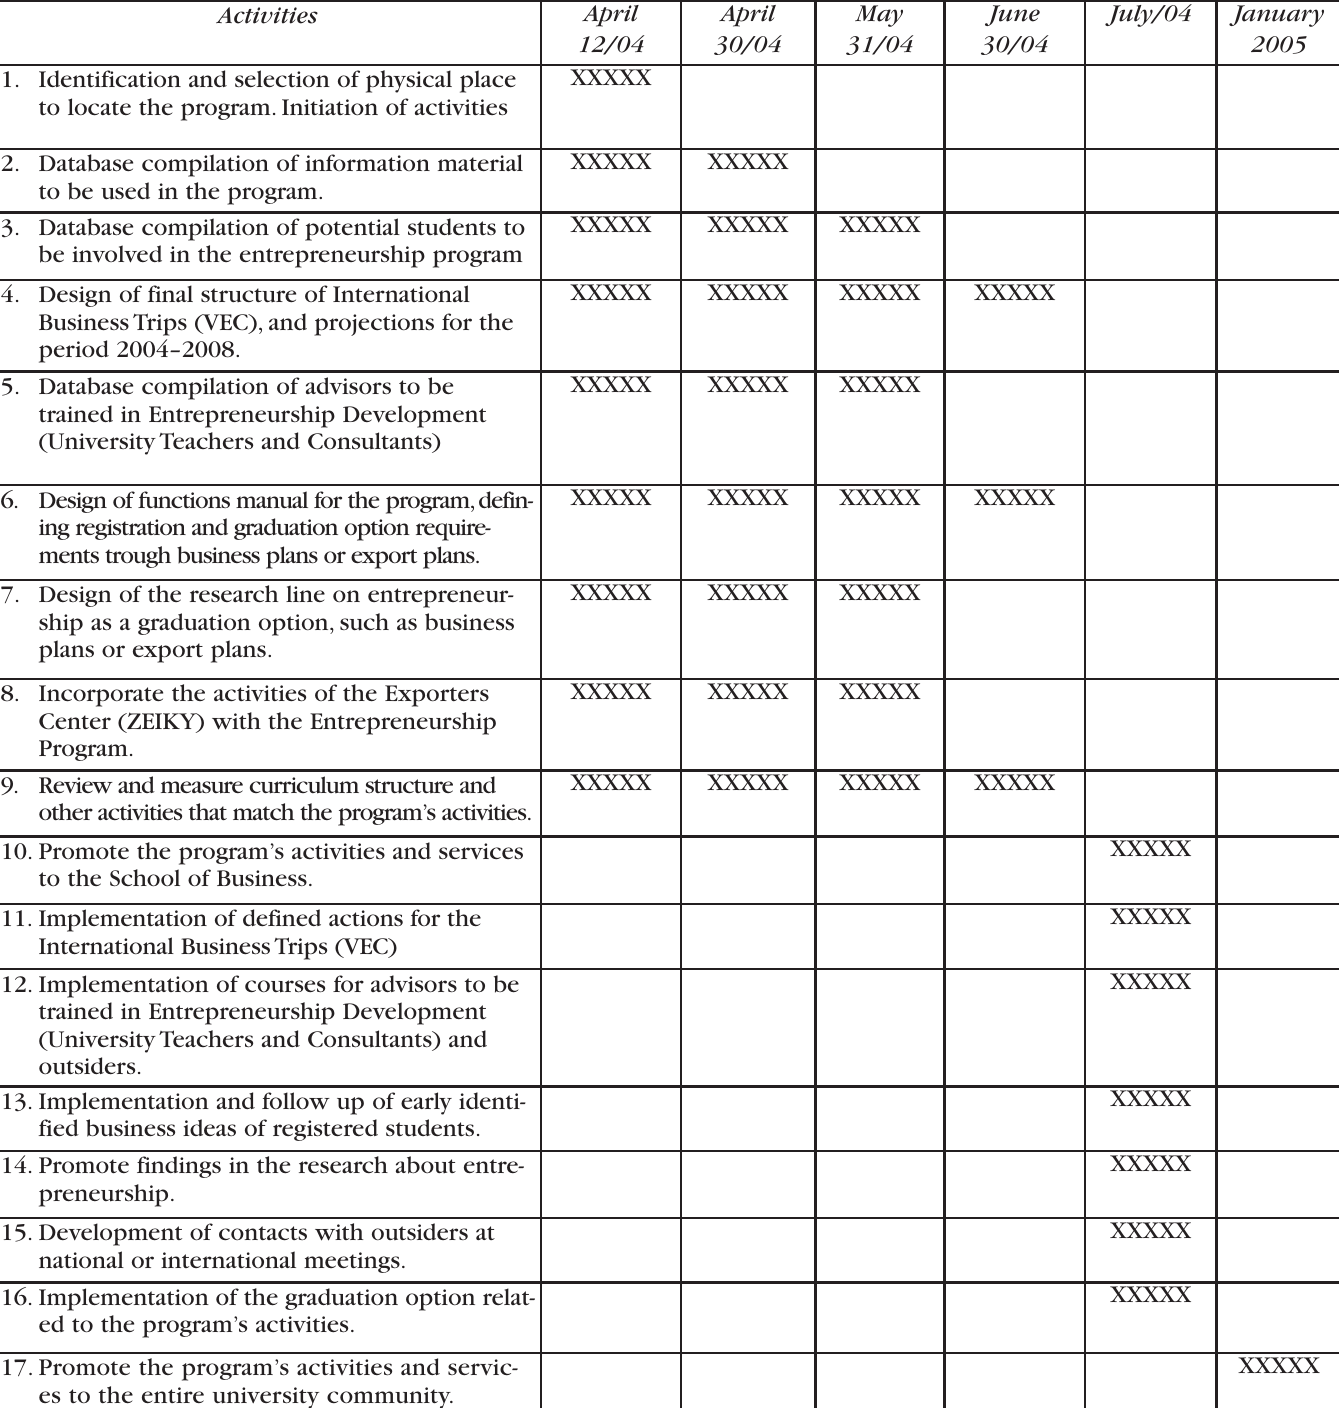
Table 1. Schedule for the Implementation of the Entrepreneurship